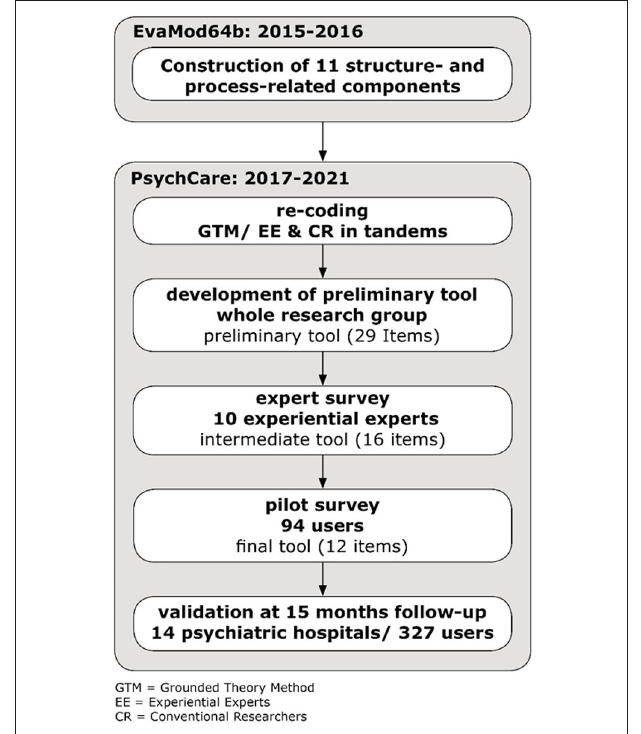
FIGURE 1 | Multi-step, collaborative construction of the NEPT research